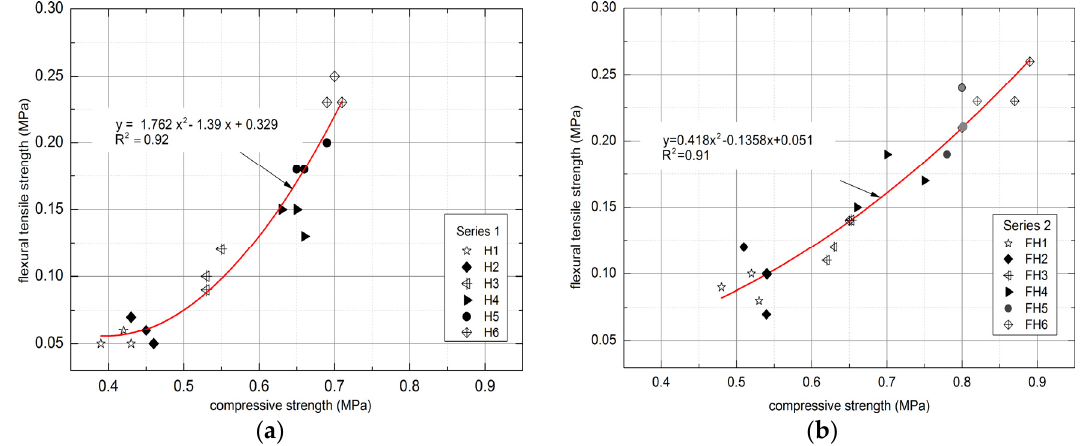
Figure 19. Relationship between compressive and flexural tensile strength of tested composites: ( a ) Series 1, ( b ) Series